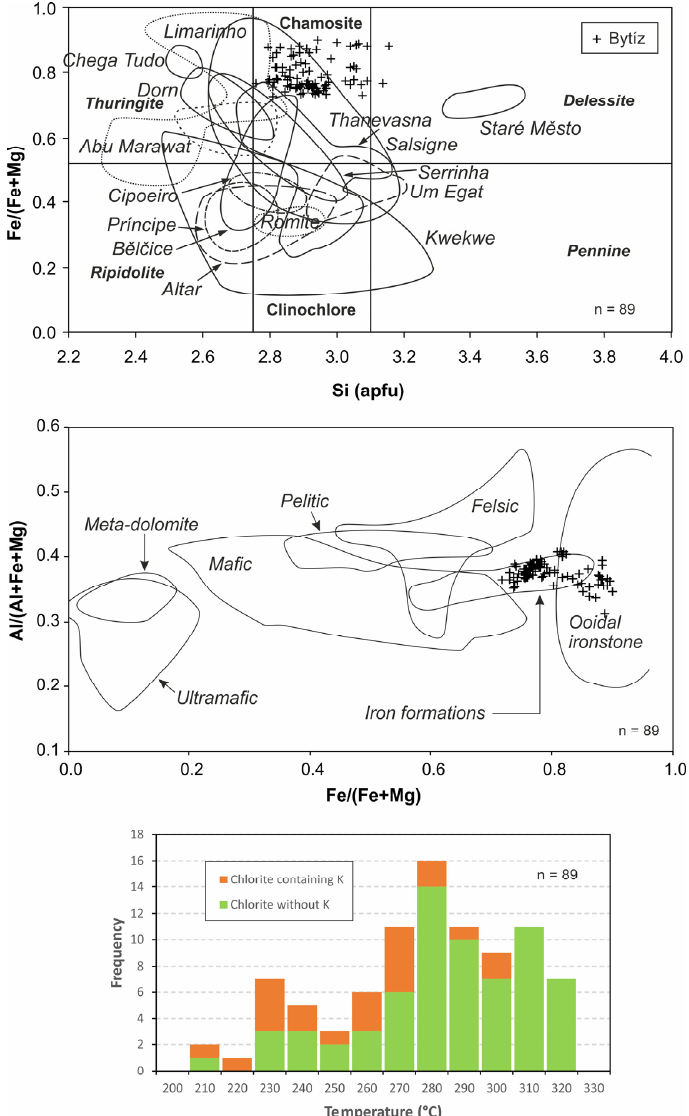
Figure 20. ( a ) Chemical composition of chlorite in the classification scheme by Melka [65] and its comparison with those of other gold deposits. Comparative data are from Demange et al. [62]; Moura et al. [66]; Buchholz et al. [67]; Klein et al. [61,68]; Zoheir et al. [69,70]; Zachariáš and Novák